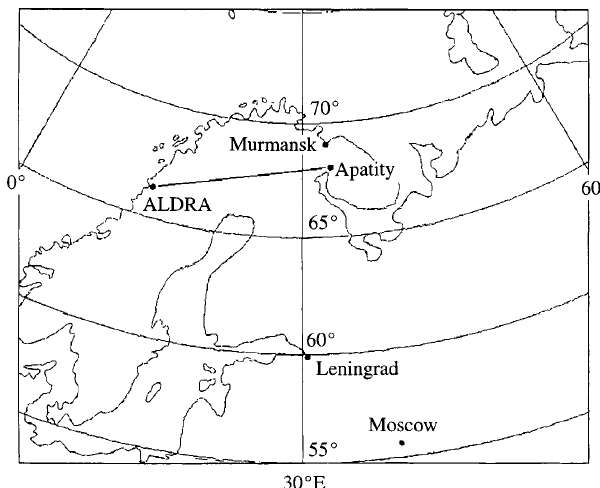
Fig. 1. Map of the VLF trace